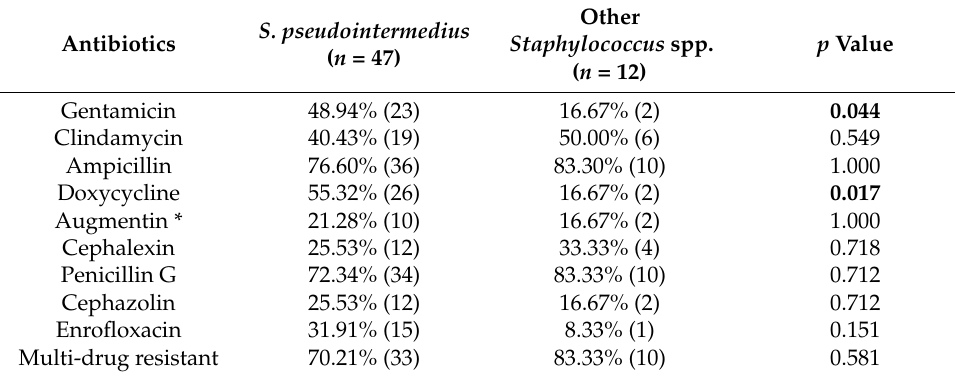
Table 1. Antibiotics resistant profiles comparing between S. pseudintermedius and other Staphylococcus spp. from dogs.